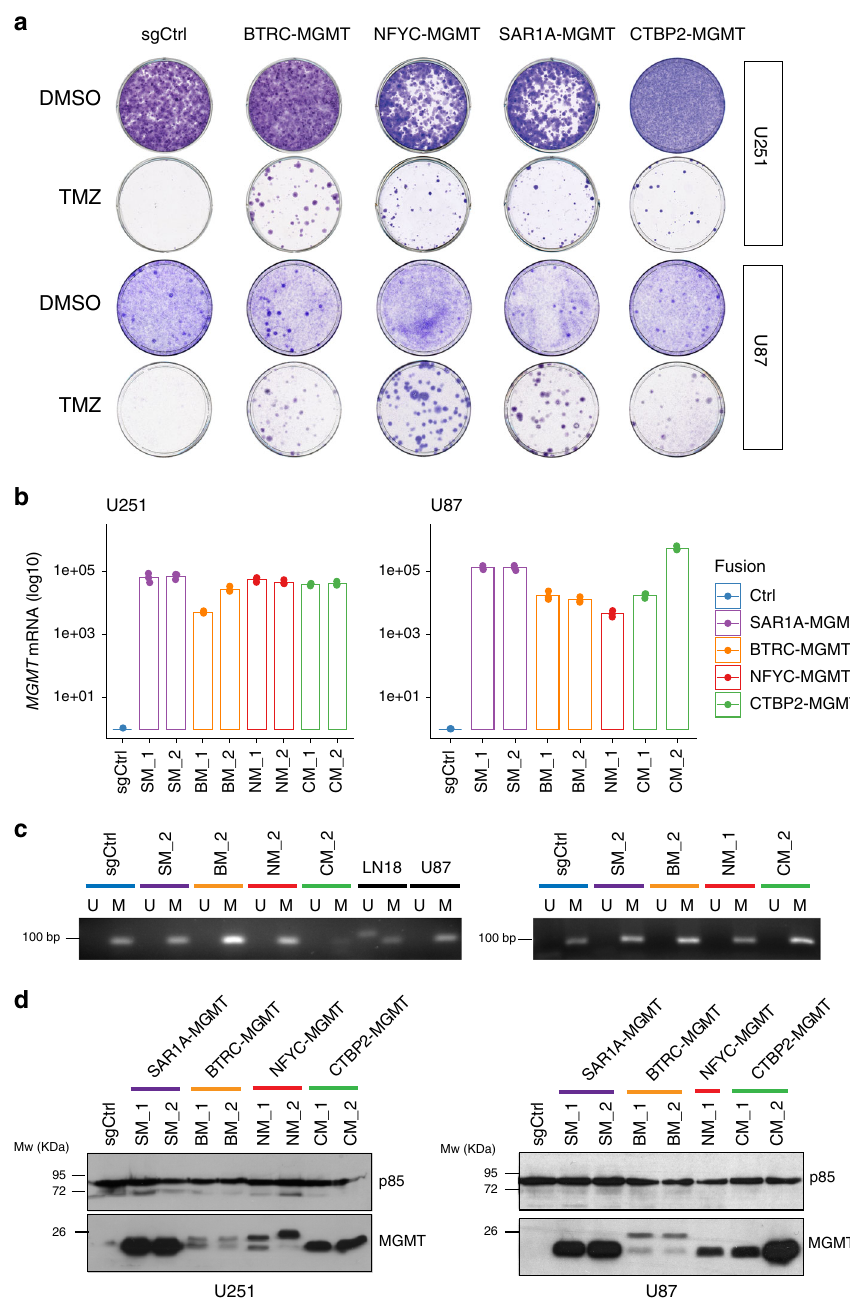
Fig. 2 MGMT fusions cells show enhanced TMZ resistance via increased MGMT expression. a Colony-forming assay performed on U251 and U87 cells expressing sgCtrl, BTRC-MGMT, NFYC-MGMT, SAR1A-MGMT, CTBP2-MGMT exposed for 12 days to TMZ (100 μ M) or DMSO. b MGMT quantitative- PCRs performed on mRNA from U251 and U87 TMZ-resistant single-cell clones expressing the indicated MGMT fusions. Data are from a representative experiment of n = 3 biological replicate. Centre of the bars represent the mean (technical replicate n = 3) and the error bars are the standard deviations. c Analysis of MGMT promoter methylation, by methylation-speci fi c PCR (MSP), in the TMZ-resistant cell clones expressing the indicated MGMT fusions from U251 (left panel) and U87 (right panel). M and U lanes indicate methylated and unmethylated status of the promoter, respectively. LN18 and U87 cells are shown as control for unmethylated and methylated, respectively. d Western blot analysis of MGMT protein levels in TMZ-resistant cell clones from U251 and U87 expressing the indicated MGMT fusions. Source data are provided as a Source Data fi